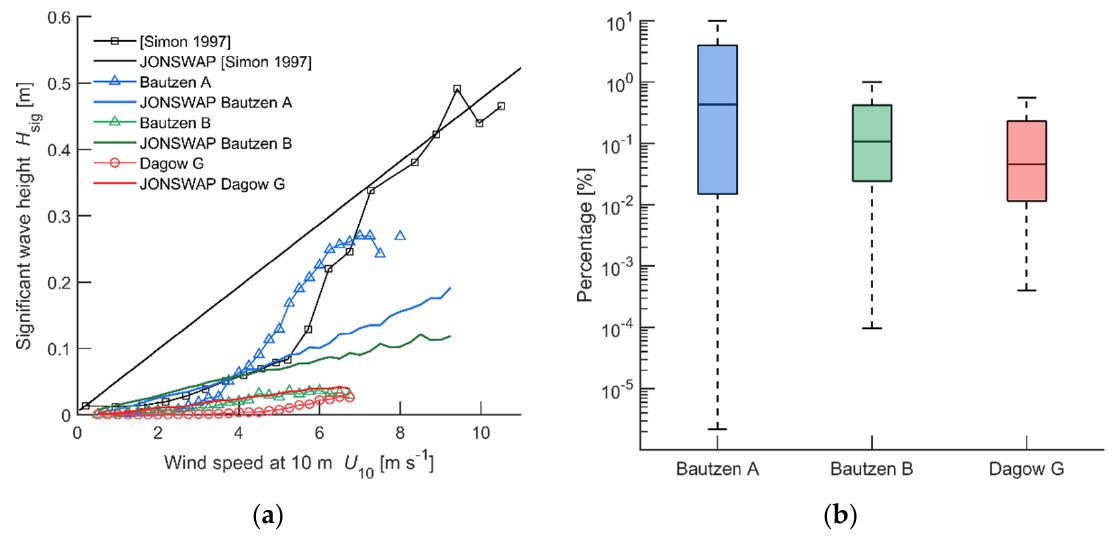
Figure 4. ( a ) Significant wave H sig as a function of wind speed U 10 . Lines with markers represent measurements: black color shows data from [18]. Blue, green and red colors represent the bin-averaged data from the present study: Bautzen Reservoir A (platform), B (shore) and Dagow Lake G (shore). Solid lines show a commonly applied empirical parameterization of the significant wave height based on the wind speed and fetch length (JONSWAP). The parameterization was applied to the observed wind speed and direction with a resolution of 30 min. ( b ) Boxplots showing the percentages of the ratio of wave energy flux per unit length of wave crest (P wave ) to the fetch-integrated wind energy flux (approximated as P 10 multiplied by the fetch length) for three measurement locations. The central horizontal line in boxes indicates the median; the bottom and top edges of the boxes denote the 25th and 75th percentiles; the whiskers extend to the largest data points which are not considered outliers.